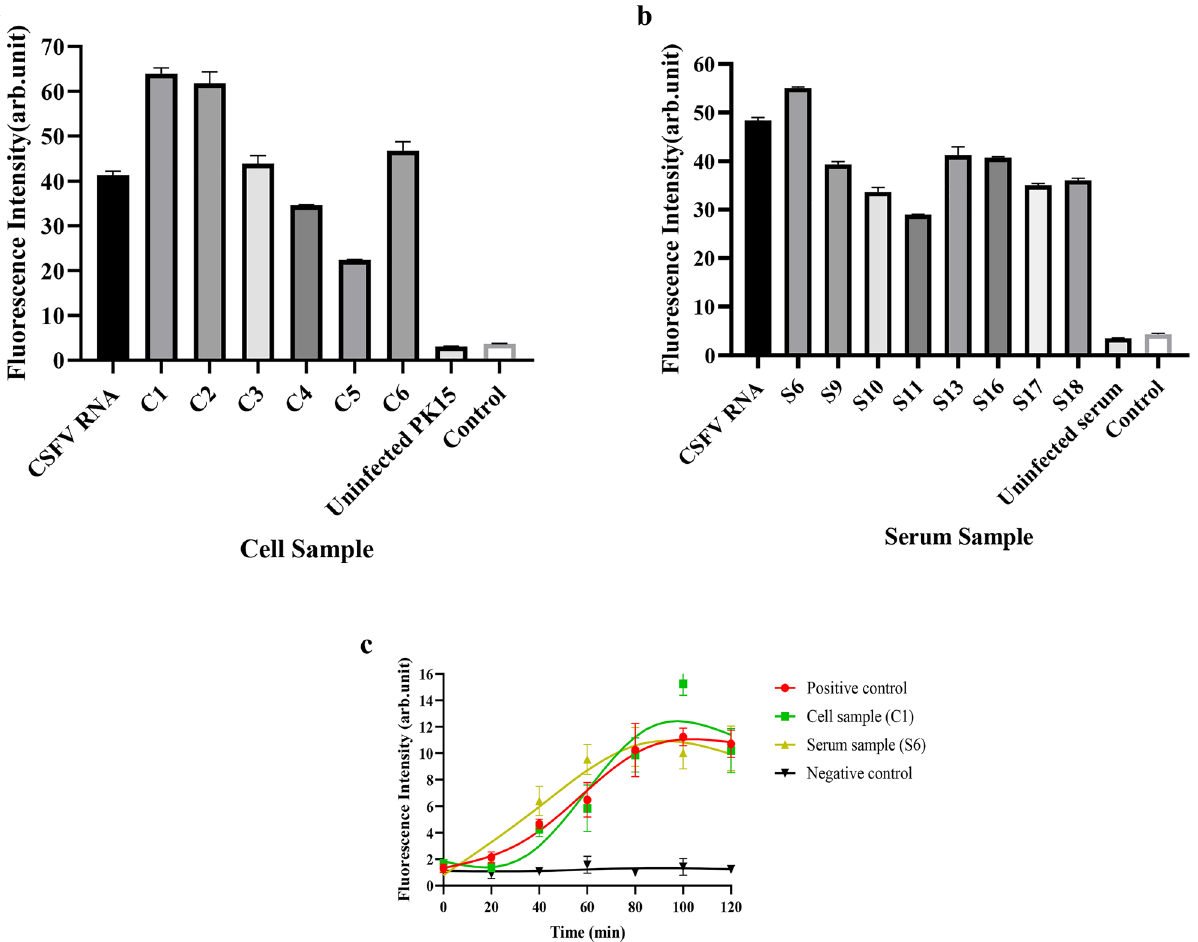
Figure 5. Detection of CSFV-infected cells and clinical pig serum by G4-ThT-NASBA system. ( a ) Detection of CSFV in cell samples (C1–C6 & uninfected PK15) CSF viral RNAs. ( b ) Detection of CSFV in serum samples (S6, S9, S10, S11, S13, S16, S17, S18 and uninfected serum) CSF viral RNAs. The fluorescence values were measured at 425 nm excitation and 490 nm emission and normalized to the value of negative control (Ct). Ct: negative control with no template added to the detection system. ( c ) The fluorescence change curve of CSFV-E2 RNA detected by real-time fluorescent G4-ThT-NASBA system is shown in red (Positive control), and the fluorescence change curve of detection without template is shown in black (Negative control). The fluorescence change curve of CSF virus RNA in cell specimens It is shown in green (Cell sample C1), and the detection fluorescence curve of CSF virus RNA in serum samples is shown in yellow (Serum sample